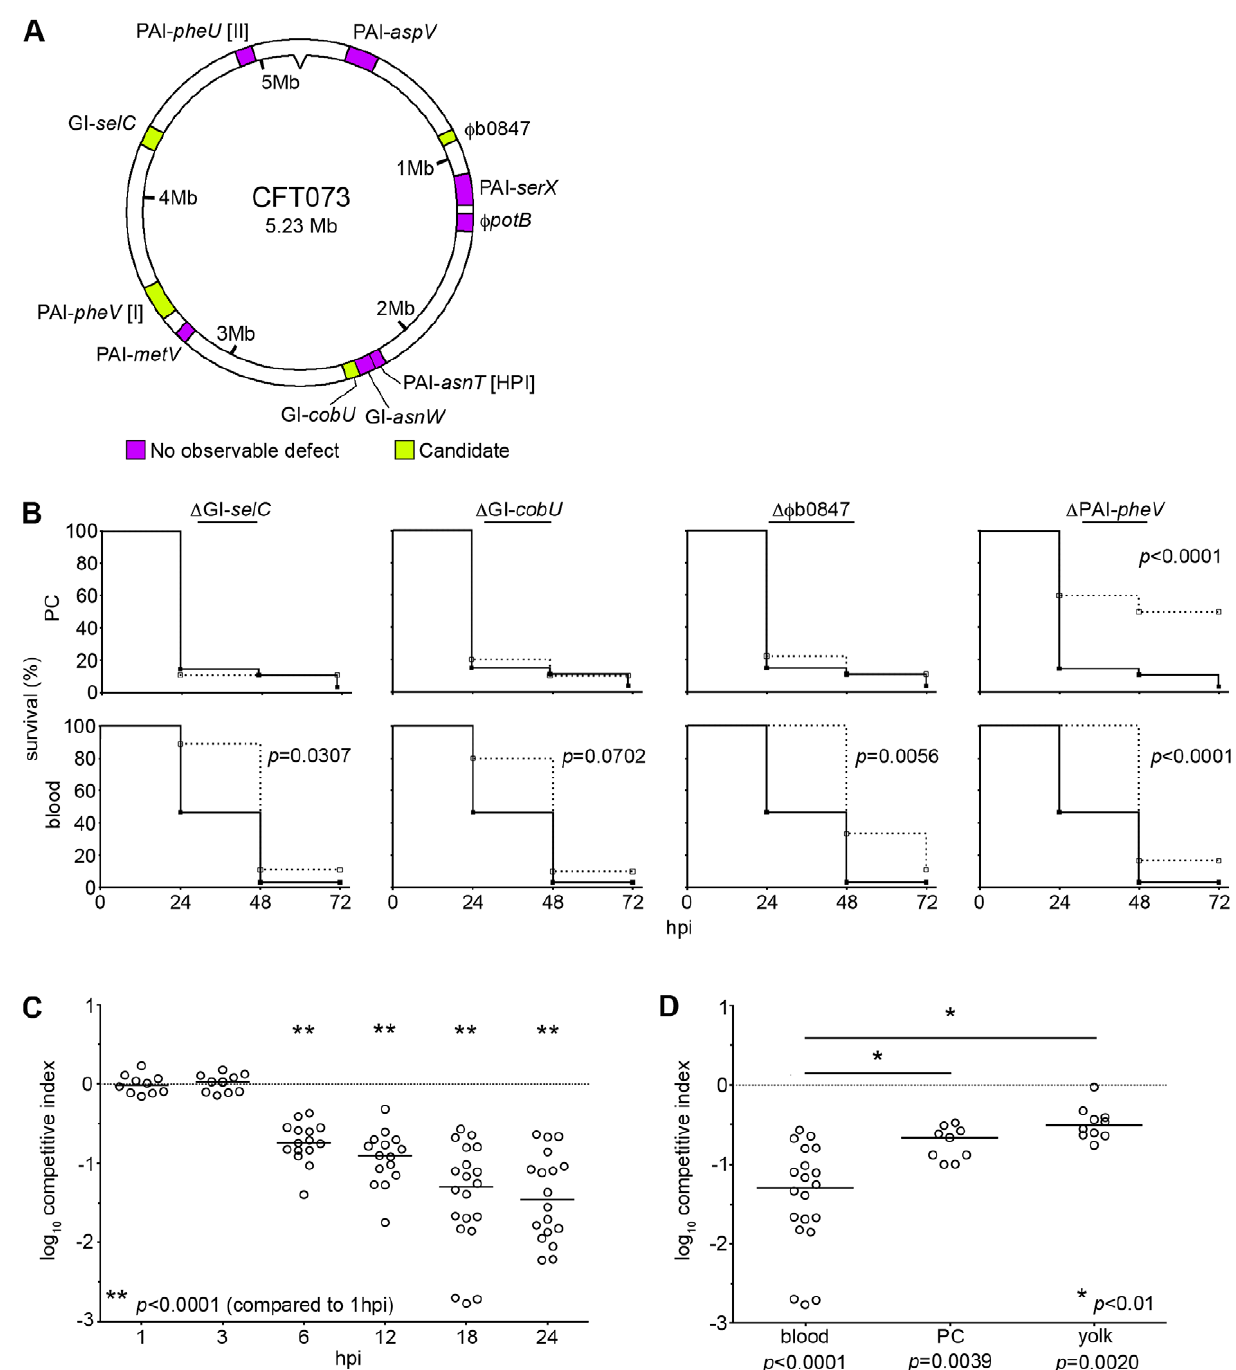
Figure 1. The w b0847 island is important for CFT073 pathogenicity during systemic infection in zebrafish embryos. (A) Diagram of GIs and their location within the CFT073 chromosome that were screened in the zebrafish host. Magenta indicates island mutants that had no observable defects, while green denotes island mutants that displayed significant attenuation. (B) The pericardial cavity (PC, top row) and blood (bottom row) of 48 hpf embryos were inoculated with 1,000–2,000 CFU. Fish were scored for death at 0, 24, 48, and 72 h post-inoculation (hpi). Data are presented as Kaplan-Meier survival plots and p values were calculated using a log-rank (Mantel-Cox) test (sample sizes for each curve are listed in Table 1). (C) Equal numbers (1,000–2,000 CFU total) of wild type and CFT073 Dw b0847 were inoculated into the bloodstream of embryos. Fish were sacrificed and bacterial loads enumerated at the indicated times by differential plating ( n =10 to 20 embryos). Data are represented as competitive indices, where negative values indicate a reduction in fitness of the mutant strain. (D) Bacteria were prepared as in (C) and inoculated into the PC or yolk. Fish were sacrificed at 18 hpi and bacterial numbers determined ( n =9–10 embryos). Data from blood infections is the same as in (C), provided as a reference. P values were determined using two-tailed Mann-Whitney t tests. Median values are indicated by bars in (C) and (D).